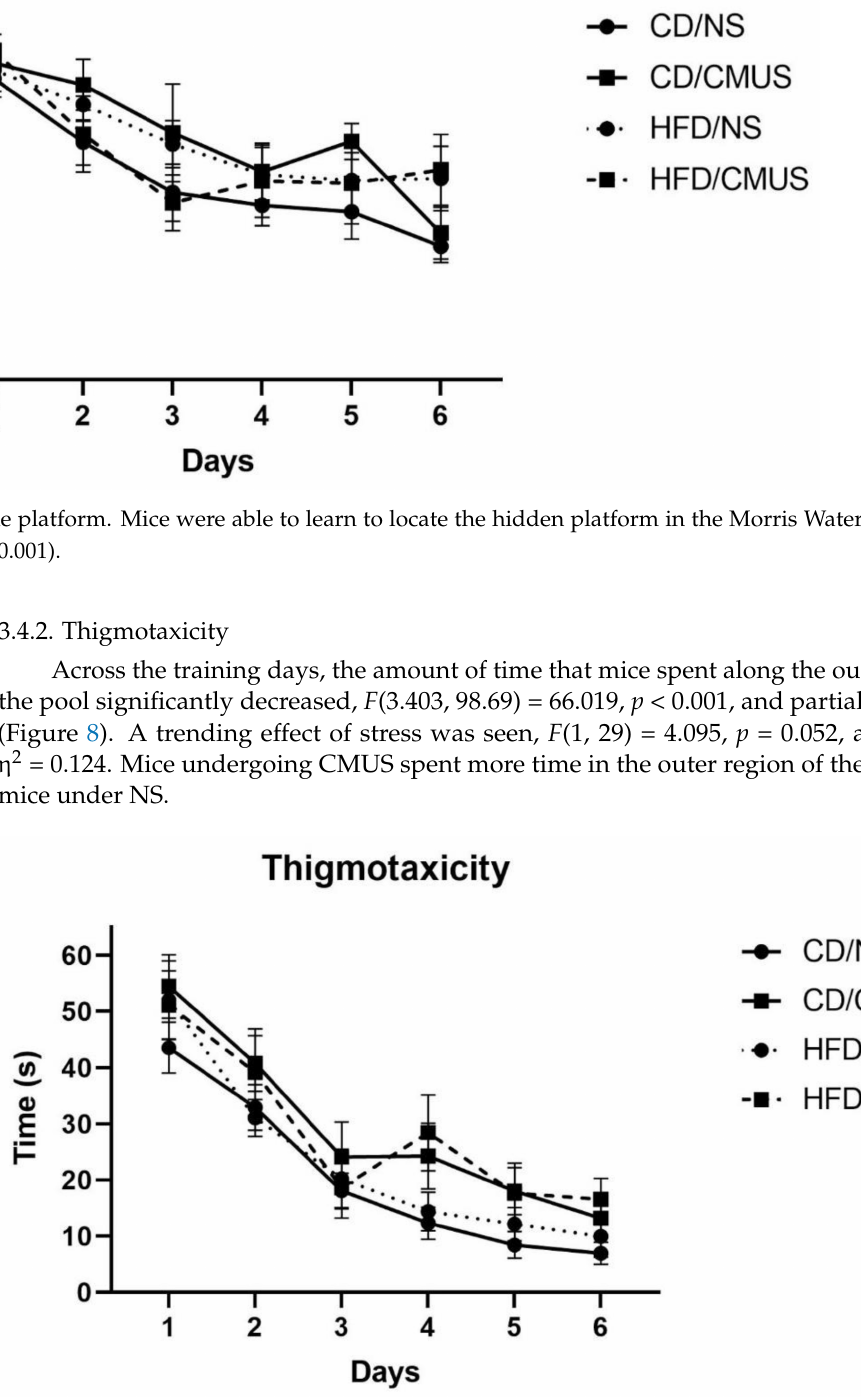
Figure 8. Thigmotaxicity across training days. Across training days, the amount of time mice spent along the border of the MWM significantly decreased ( p <